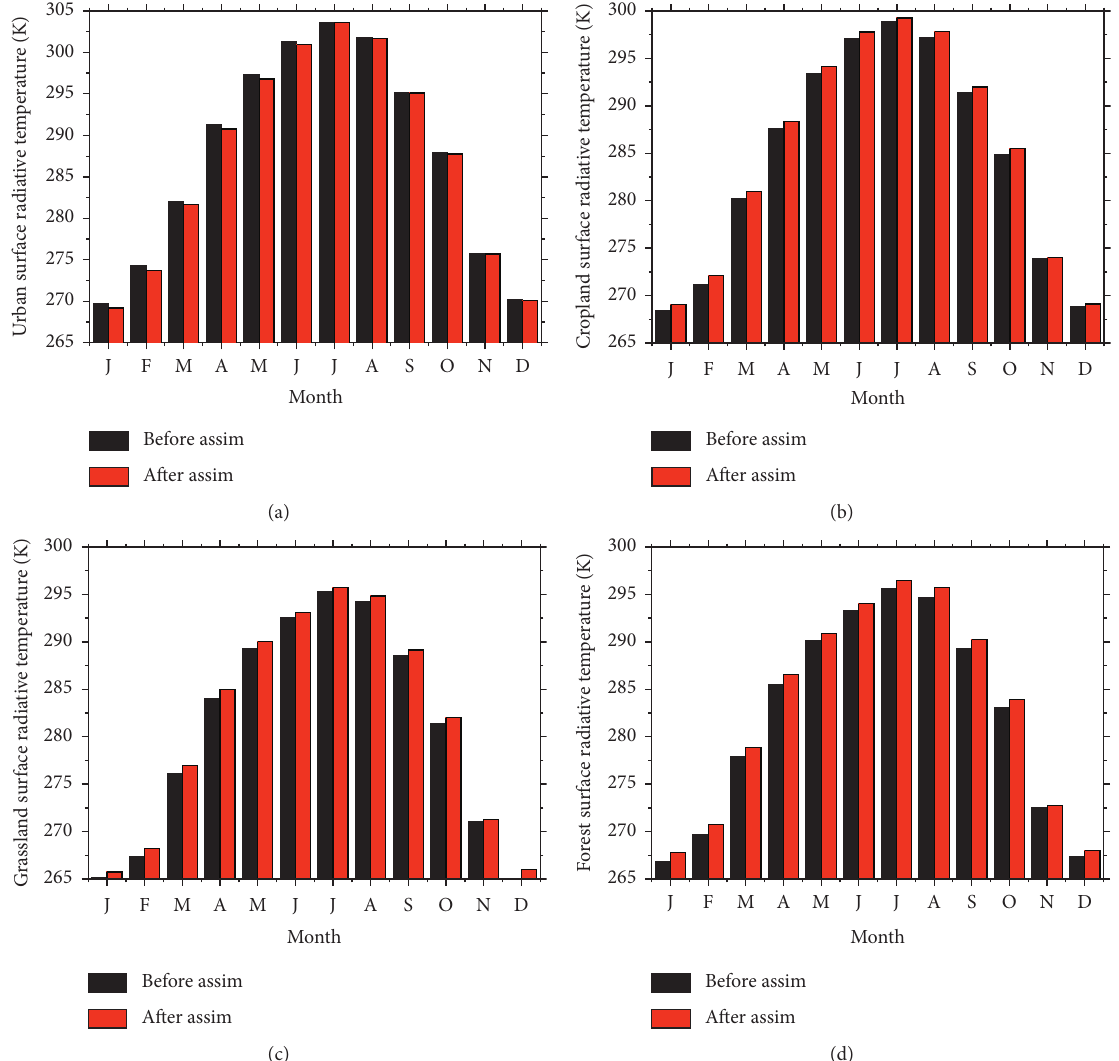
Figure 11: Spatial average of the monthly average surface radiative temperature simulations before and after assimilation for the four main LUCs: (a) urban; (b) cropland; (c) grassland; (d)